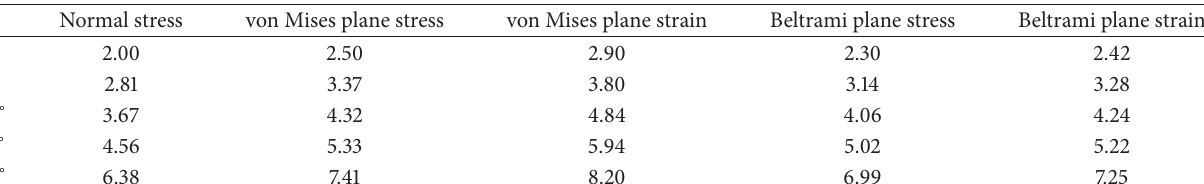
Figure 2: Application of the notch rounding approach to mode I loading. Table 1: Microstructural support factor 𝑠 (plateau values) of tension-loaded V-notches for different failure criteria under plane stress and plane strain conditions.